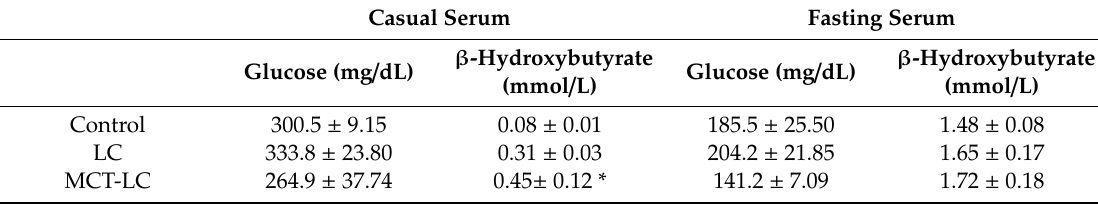
Table 1. Casual serum and fasting serum glucose and β -hydroxybutyrate. Casual Serum